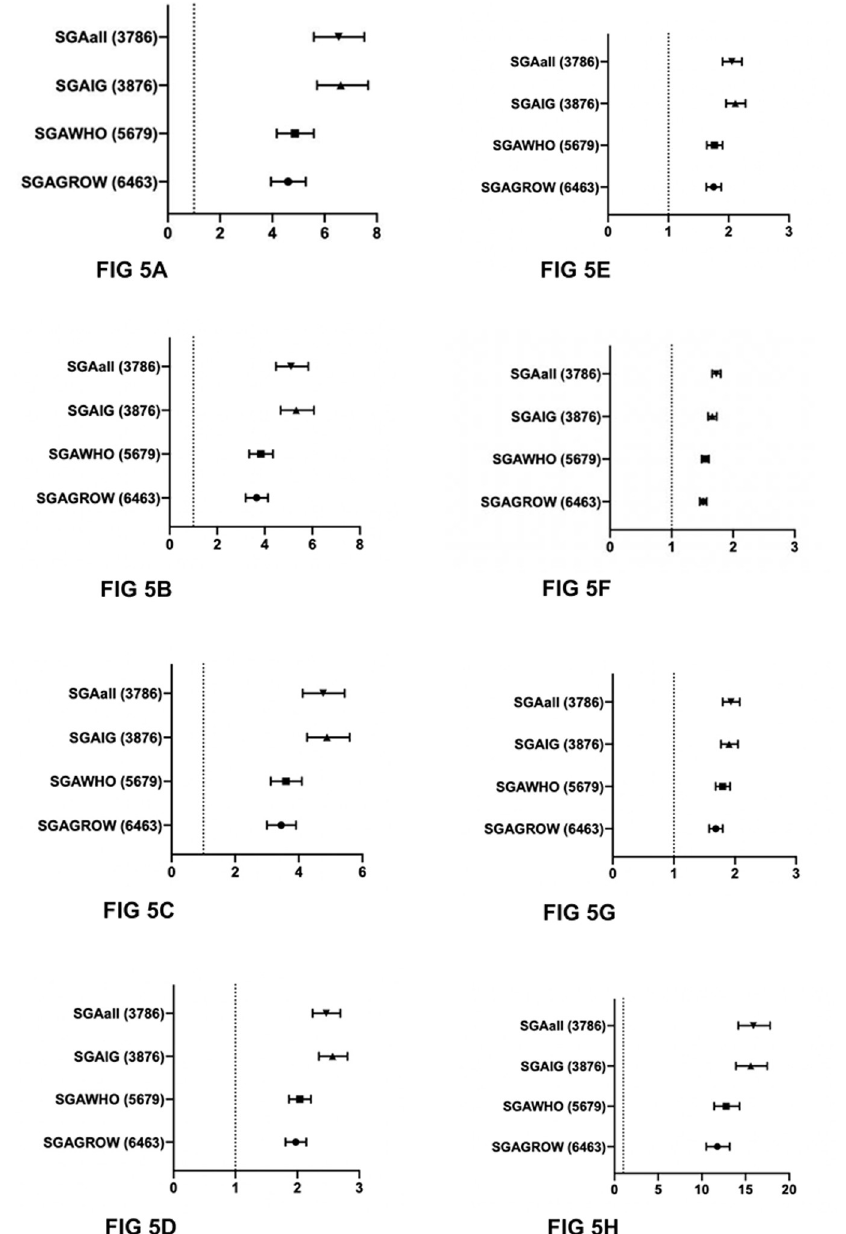
Fig 5. Relative risk ratios of < 10th centile populations for adverse outcomes by fetal charts INTERGROWTH, WHO, and GROW, compared with the AGA all population. (A) Stillbirth. (B) Perinatal mortality (stillbirth or neonatal death). (C) Apgar < 4 at 5 minutes. (D) Apgar < 7 at 5 minutes. (E) Neonatal intensive care unit admission. (F) Unplanned (emergency) cesarean section rate. (G) Fetal distress indication for operative delivery. (H) Suspected poor fetal growth indication for induction or operative birth. AGA all , appropriate size for gestational age by all intrauterine charts; GROW, Gestation Related Optimal Weight; SGAall, small for gestational age by all intrauterine charts; SGAIG, small for gestational age by INTERGROWTH fetal charts; SGAWHO, small for gestational age by WHO fetal charts; SGAGROW, small for gestational age by GROW customised centiles.